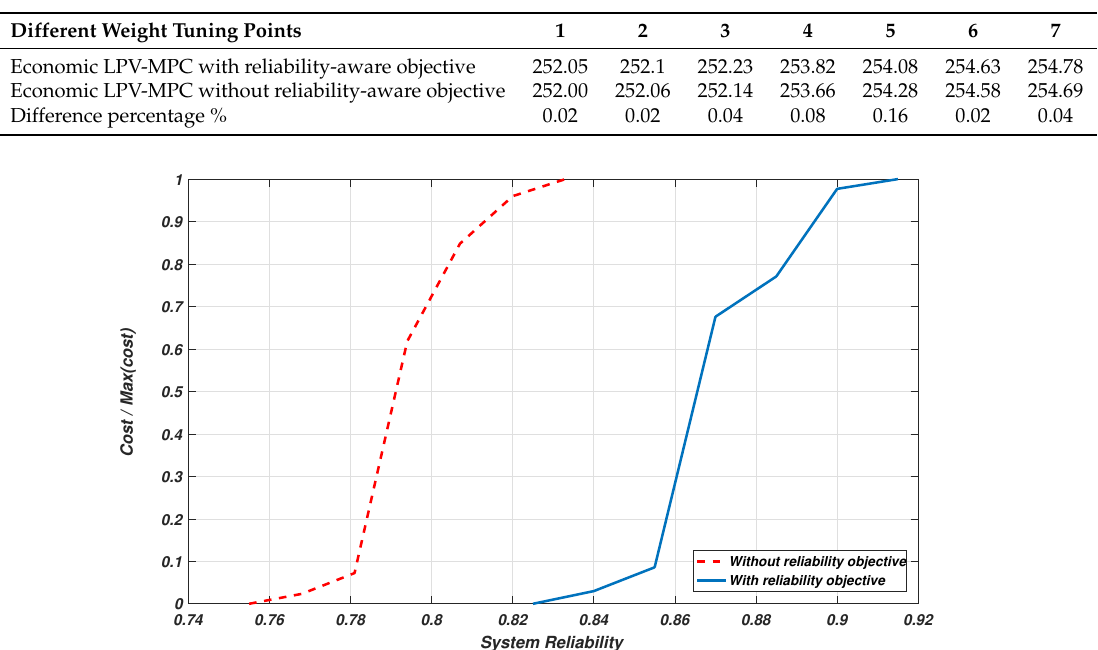
Figure 13. Final system reliability vs. economic cost for different weight